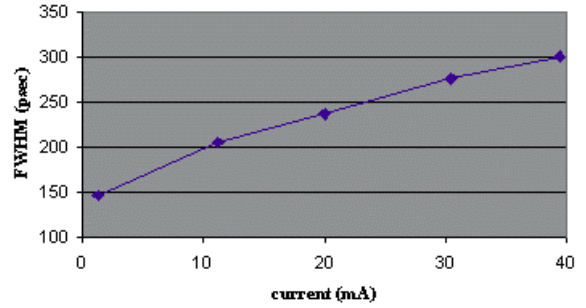
FIG. 11. (Color) Bunch length versus single bunch current: e (cid:1)